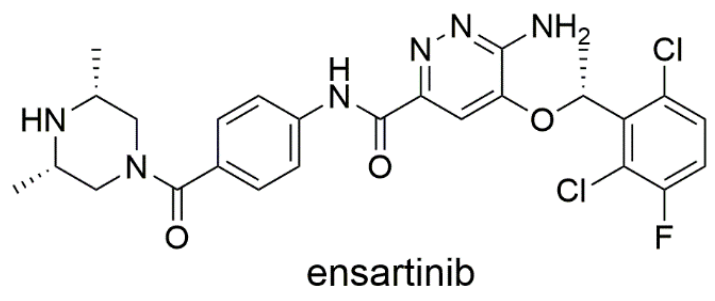
Figure 1. Chemical structure of ensartinib.